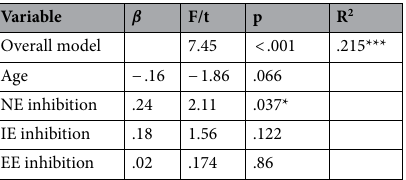
Table 2. A linear regression analysis for prediction of depression level (PHQ-9 total score). *p < 0.05, ***p < 0.001.